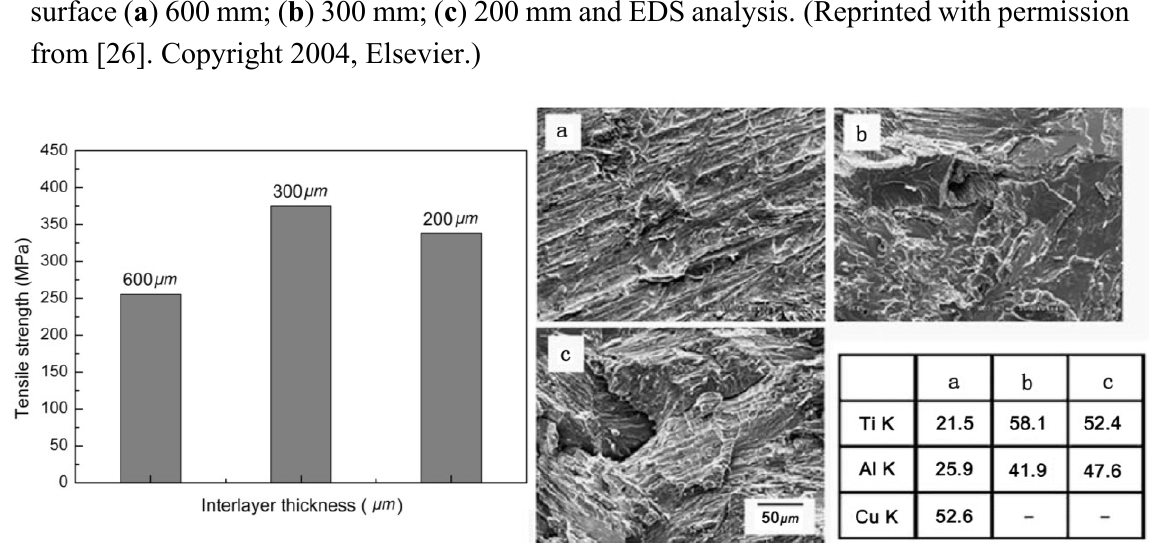
Figure 13. Tensile strength variations with various insert layer thickness, SEM fracture surface ( a ) 600 mm; ( b ) 300 mm; ( c ) 200 mm and EDS analysis. (Reprinted with